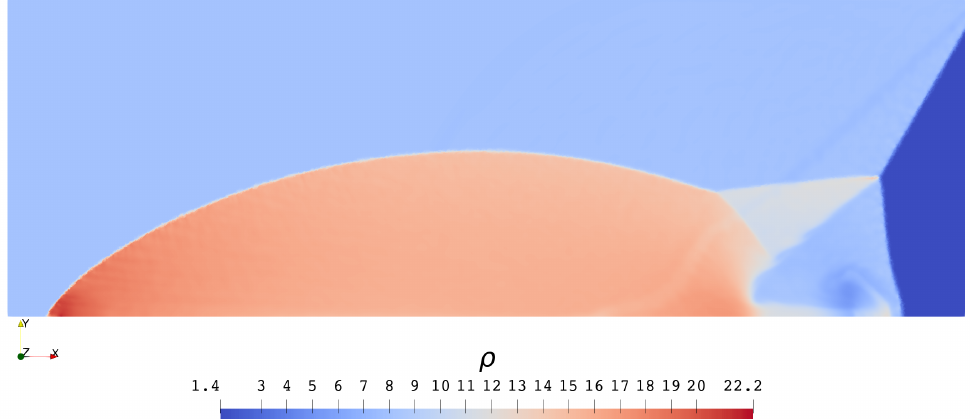
Figure 21. Second-order solution of ρ ( x , y , z = 0, t = 0.2 ) in Problem 6 ( h ≈ 1/200).